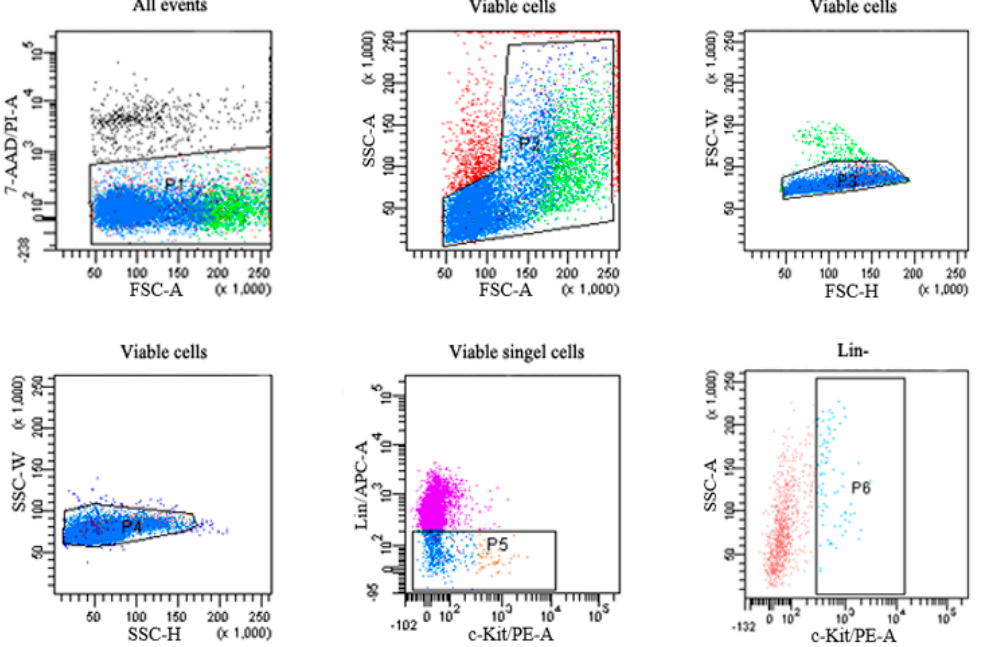
Figure 5. Gating strategy for detection and sorting various hematopoietic progenitor cells in the bone marrow by FACS. P1 is gated on the viable bone marrow cells from all events; P2 is gated on the P1-gated viable cells; P3 is gated on the P2-gated cells to remove doublets ; P4 is gated on the P3-gated cells to remove doublets; P5 is gated on Lin − c cells from P4-gated cells; P6 is gated on Lin − c-Kit + cells from P5-gated cells.